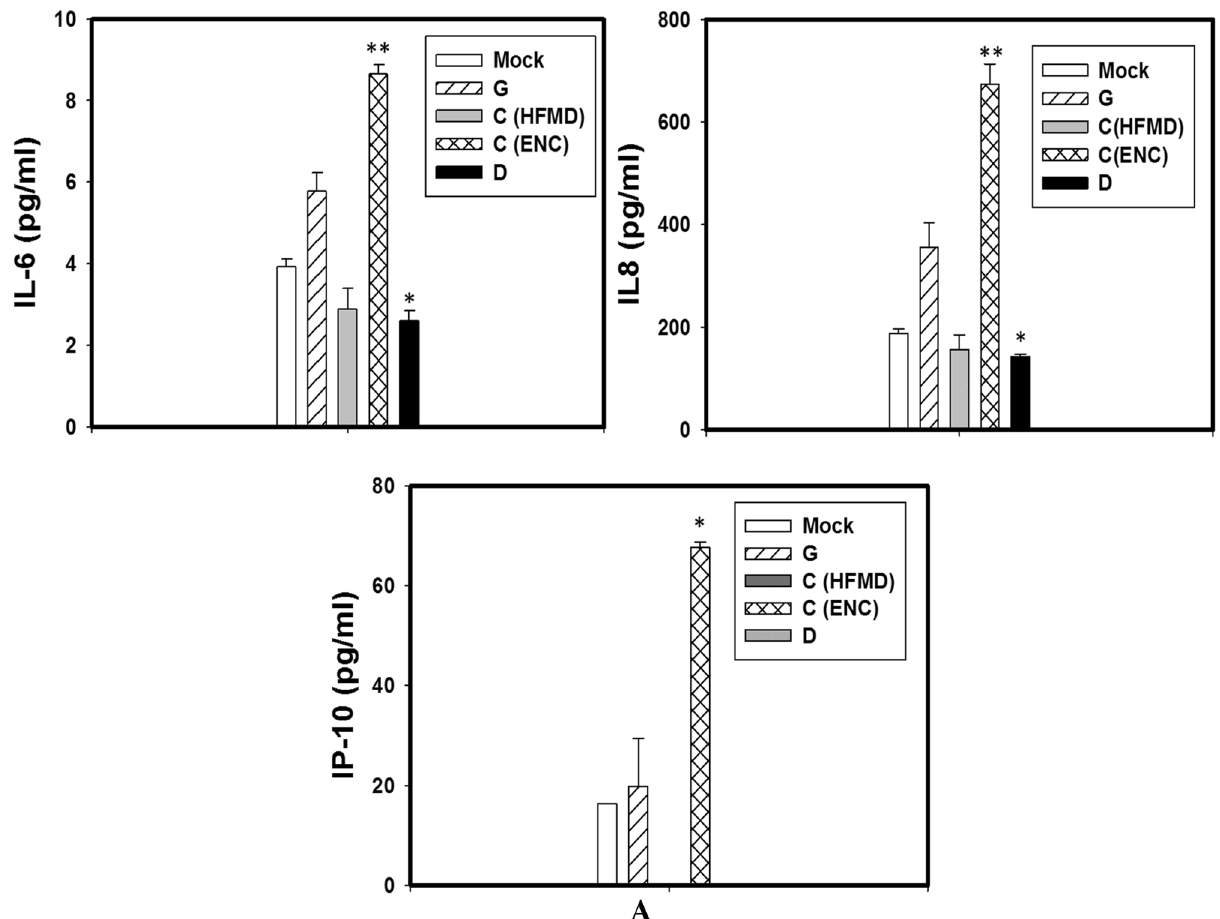
Figure 4. SK-N-SH cells were mock-infected or infected with EV-A71genotypes at an MOI of 1 for different time points. The cytokine and chemokine secretion profiles of human neuronal cells infected with different EV-A71 genotypes at ( A ) 12 h post infection, ( B ) 24 h post infection, and ( C ) 48 h post infection, showed significant differences between the indigenous genotypes. ( D ) RD-A cells were mock-infected or infected with EV-A71genotypes at an MOI of 1 for different time points and IFN-α level as quantified. Three independent experiments were performed for each virus strain. The statistical analyses were performed using Sigma Plot (Sigma Plot for Windows version 10, Copyright 2006, Systat Software, Inc. Palo Alto, CA, USA) using student’s t test. * p value < 0.05; ** p value < 0.01; *** p value < 0.001. All p values stated were referenced to the mock infected